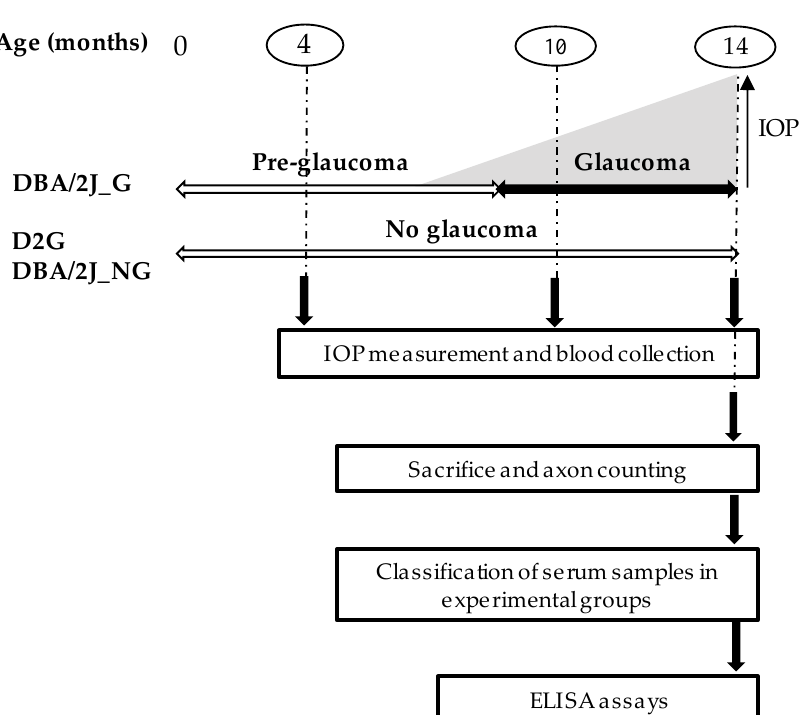
Figure 1. Experimental design. Intraocular pressure (IOP) analysis and blood collection were carried out at 4, 10, and 14 months for systemic proteins screening. The D2G and DBA / 2J mice were ultimately sacrificed at 14th month and serum samples classified according to the number of axons. DBA / 2J_G: mice that developed glaucoma with the age; D2G and DBA / 2J_NG: mice without signs of glaucoma.